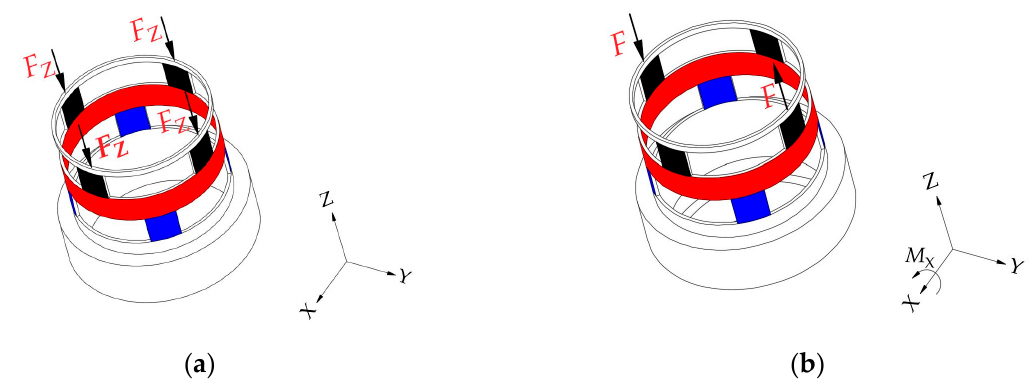
Figure 9. Force diagram of the cylindrical traction force sensor: ( a ) under the force F Z ; ( b ) under the torque M X .